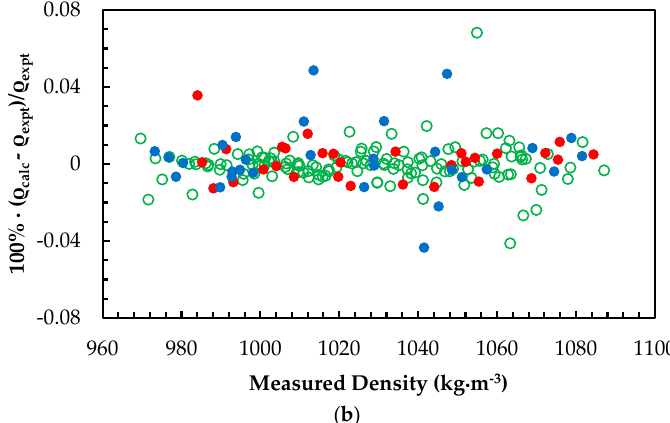
Figure 3. ( a ) Comparison of correlated density with measured density for 2-amino-2-methyl-1-propanol (AMP) + MEA + H 2 O + CO 2 mixtures. ANN: Training data, ‘ ◦ ’; Validation data, ‘ • ’; Test data, ‘ • ’. Modified Weiland’s correlation, ‘x’. ( b ) Percentage deviation of correlated density from measured density for AMP + MEA + H 2 O + CO 2 mixtures. ANN: Training data, ‘ ◦ ’; Validation data, ‘ • ’; Test data, ‘ • ’.